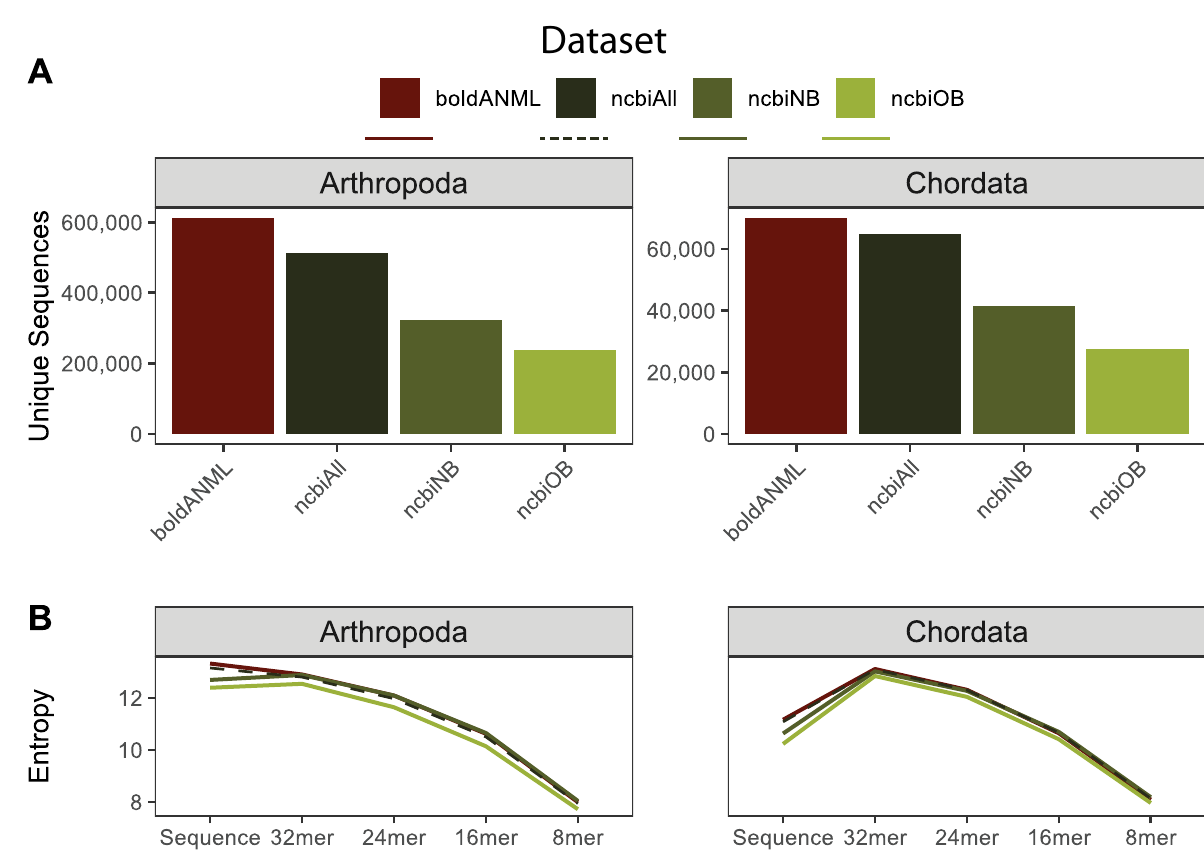
Fig 12. Comparison of sequence information from BOLD and NCBI GenBank COI gene databases for available arthropod and chordate sequences. All sequences were dereplicated and trimmed to a common primer region. NCBI references either contained a cross-reference term to BOLD (“ncbiOB”) or not (“ncbiNB”) or were combined together (“ncbiAll”). A, Number of unique sequences (note difference in scales between Arthropoda and Chordata). B, Entropy of sequences and different kmer